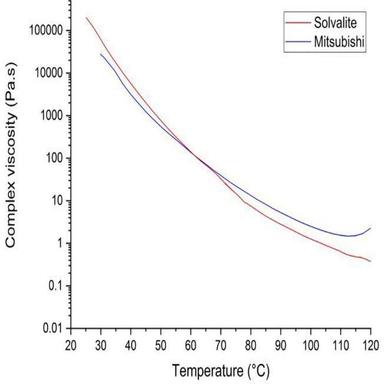
A comparison of viscosity profiles of epoxy resins used in the CEP-TW1 (Solvalite), and CEP-TW2 and CEP-UD (Mitsubishi) prepregs as a function of temperature (from material suppliers' data).